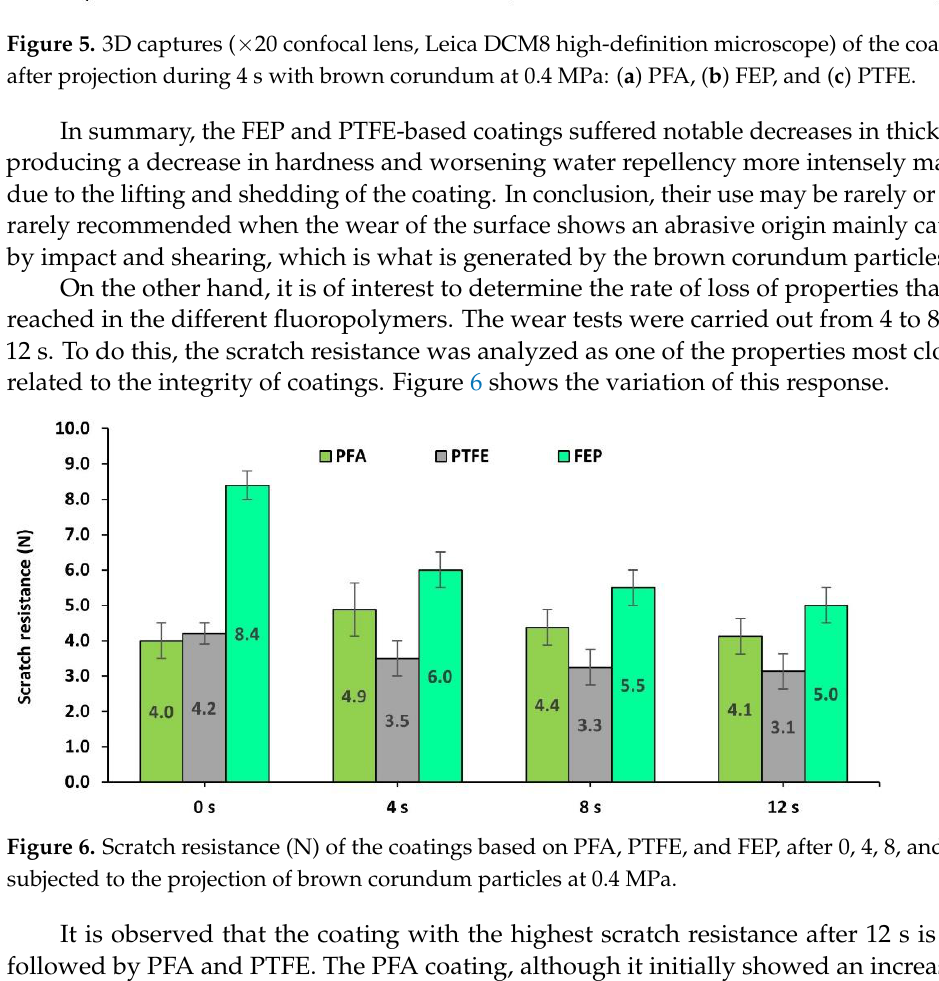
Figure 5. 3D captures (x20 confocal lens, Leica DCM8 high-definition microscope) of the coatings after projection during 4 s with brown corundum at 0.4 MPa: ( a ) PFA, ( b ) FEP, and ( c ) PTFE.